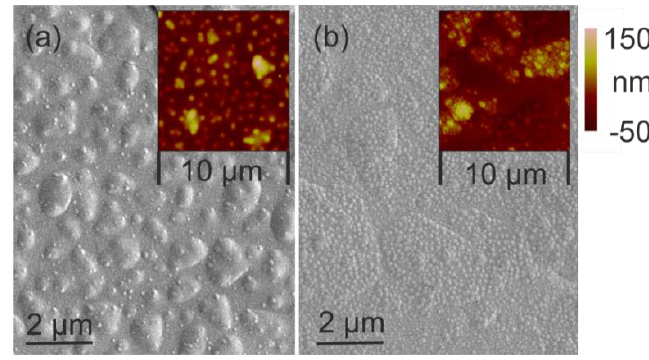
Figure 9. SEM image and AFM-Plot of the sample surface in experiment #6: ( a ) silicon; ( b ) ceramic.